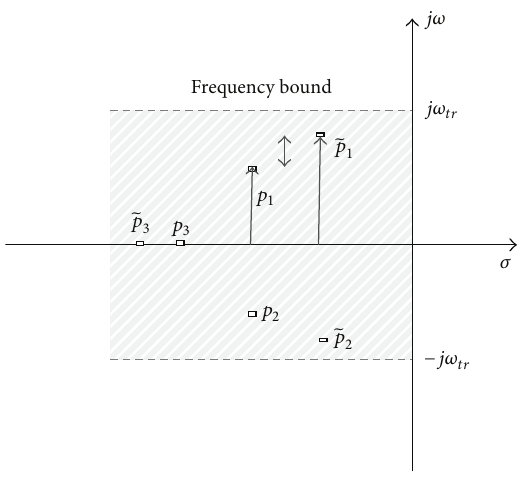
Figure 3: Rise-time objective function with a horizontal bound- ary ±𝑗𝜔 𝑡𝑟 .